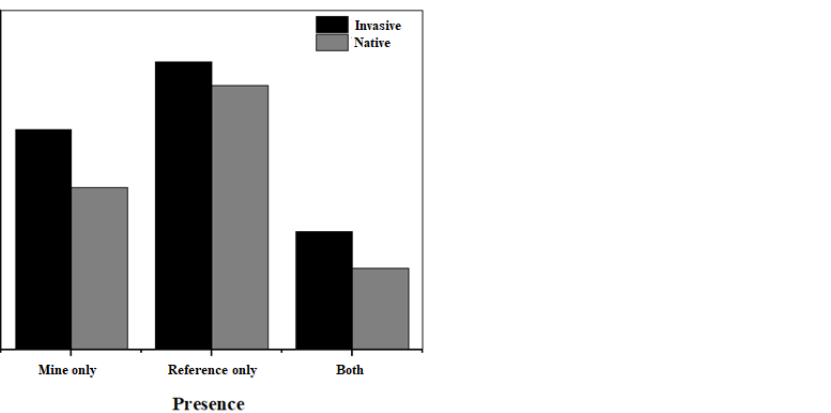
Table 2. Chi-square test results comparing the number of individuals of invasive versus native species: (a) across all sites, (b) among site pairs (mine sites and adjacent reference sites). Bold p - values indicate statistically significant differences.